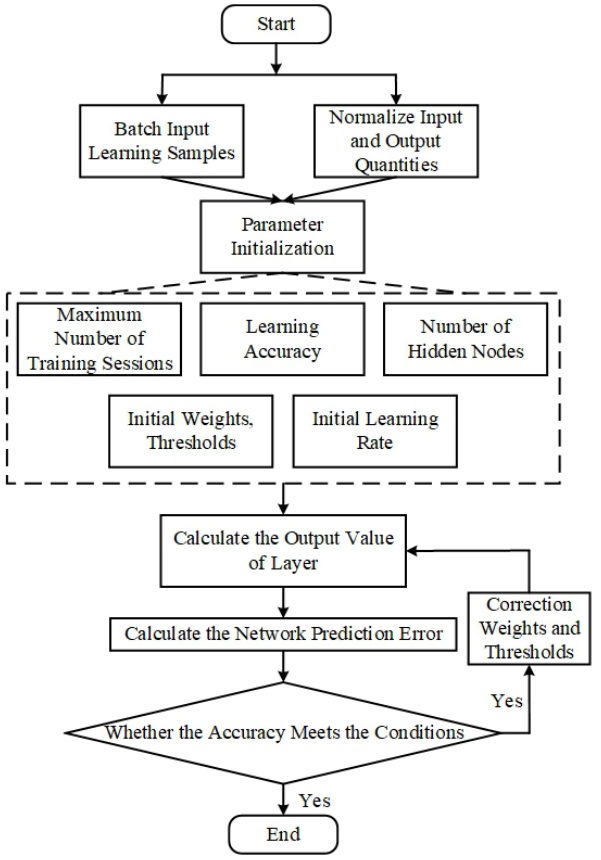
Figure 3. Flowchart of BP